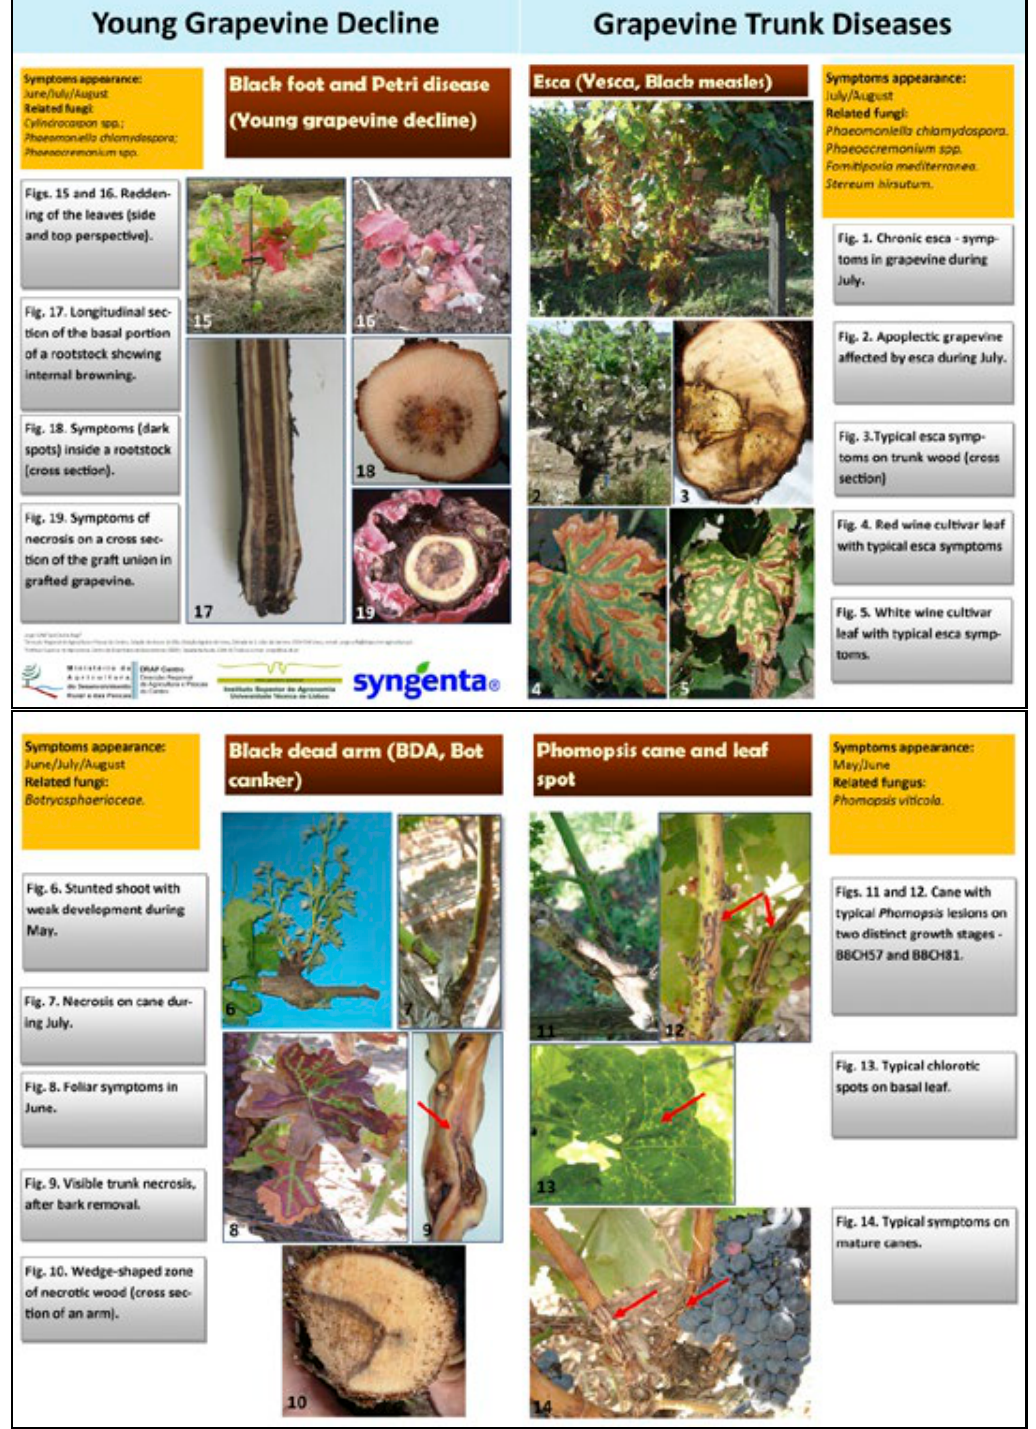
Figure 2. Leaflet produced for divulgation of the main symptoms of grapevine trunk diseases affecting the Dão wine region (English